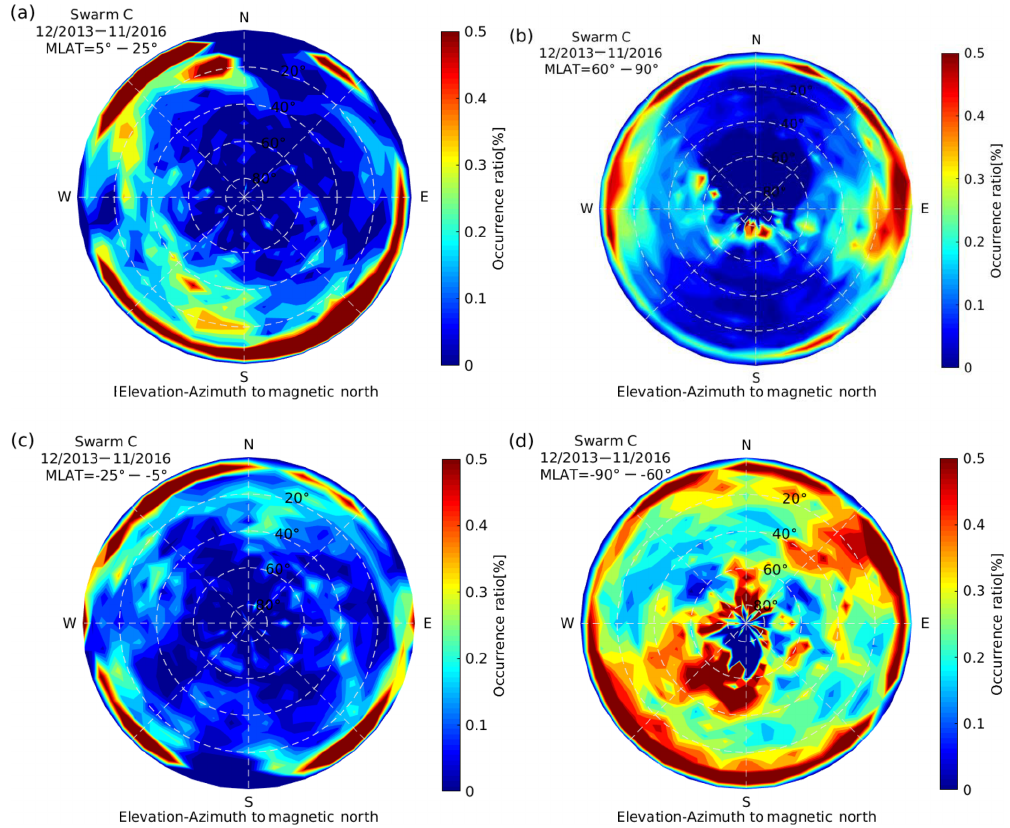
Figure 8. The elevation and azimuth distribution of GPS signal loss events at (a) northern and (c) southern low latitudes observed by Swarm C. The azimuth angle is calculated with respect to the magnetic north. (b) and (d) are similar to (a) and (c) but for the high latitudes in both